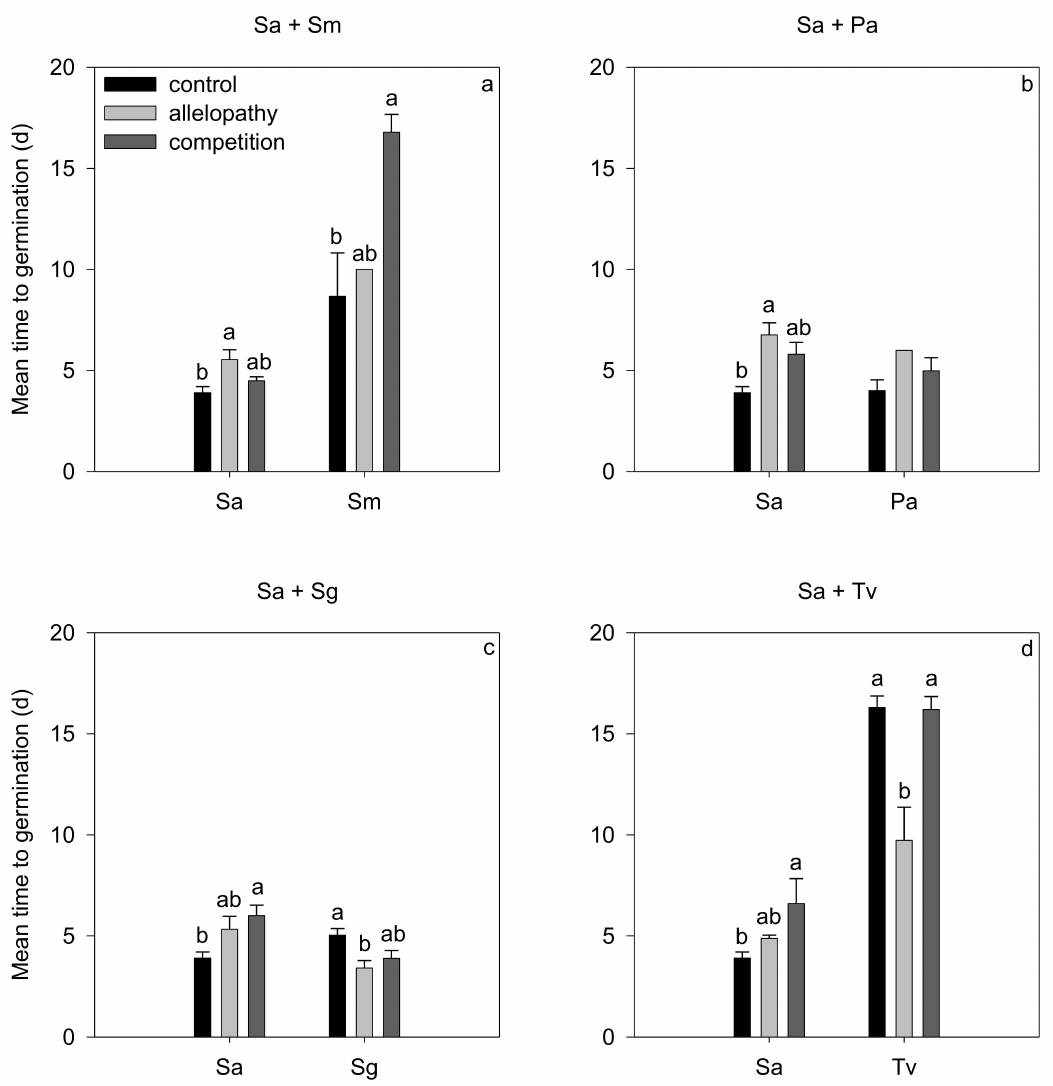
Figure 3. Mean time to seed germination of invasive Spartina alterniflora (Sa) and four native species ( Scirpus mariqueter , Sm, Phragmites australis , Pa, Suaeda glauca , Sg, and Tripolium vulgare , Tv) in different interspecific interaction treatments (control: target species in monoculture, allelopathy: target species seeds + competitor seeds leachate, competition: target species seeds + competitor seeds in mixture). ( a ) Species combination of Sa + Sm, ( b ) Species combination of Sa + Pa, ( c ) Species combination of Sa + Sg, ( d ) Species combination of Sa + Tv. Different lower cases denote significant differences among different interspecific interaction treatments of the same species. Error bars are standard